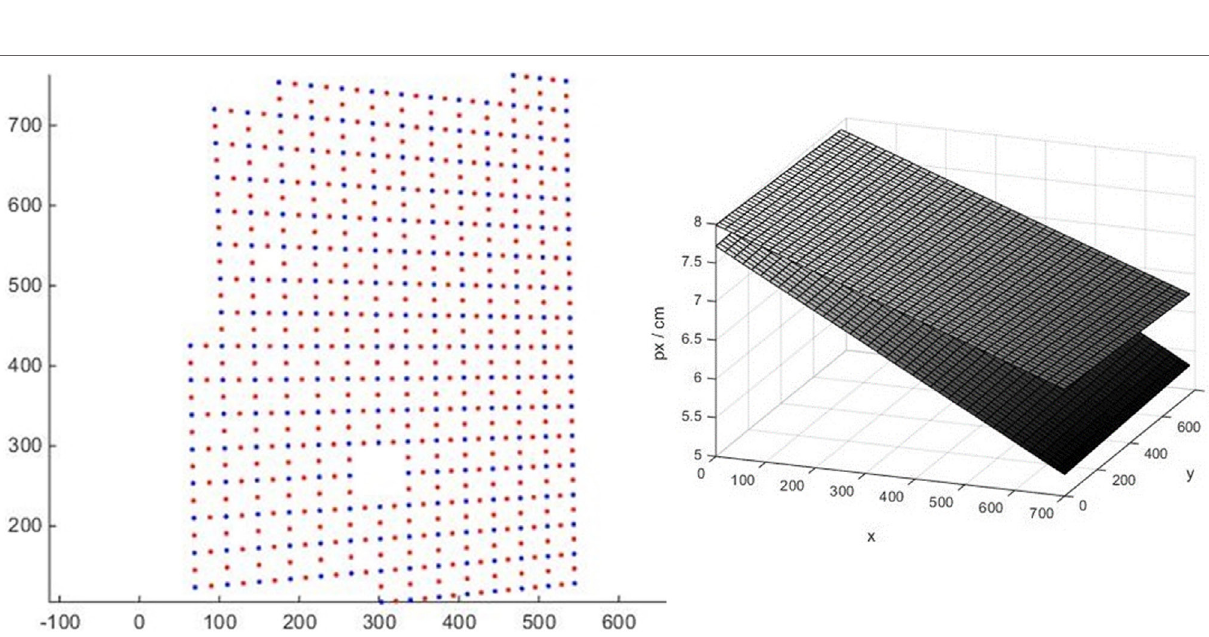
FIgURe 4 | An example of resulting 3D polynomials for x and y corrections due to lens distortion. All units are in pixels.